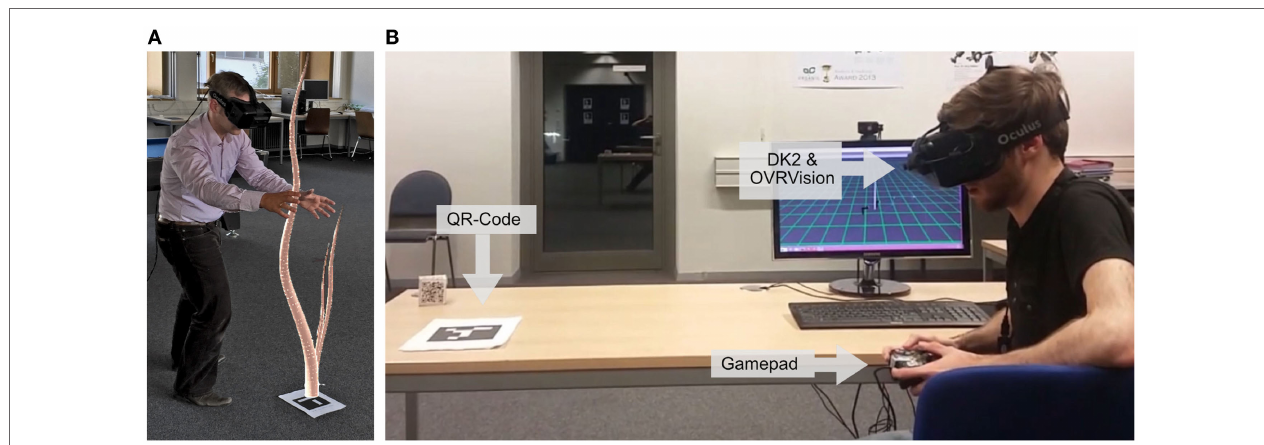
FigUre 8 | (a) Mock-up of an augmented reality situation where a plant-like structure grows from the floor that the user can interact with. (B) Overview of the robot gardens augmented reality prototype: a stereoscopic camera (OVRVision) extends the functionality of a head-mounted virtual reality display (an Oculus DK2). The camera feed is funneled through to the DK2. Easily detectable QR-markers allow one to place virtual objects in space, at absolute coordinates. A gamepad acts as a simple control interface for the